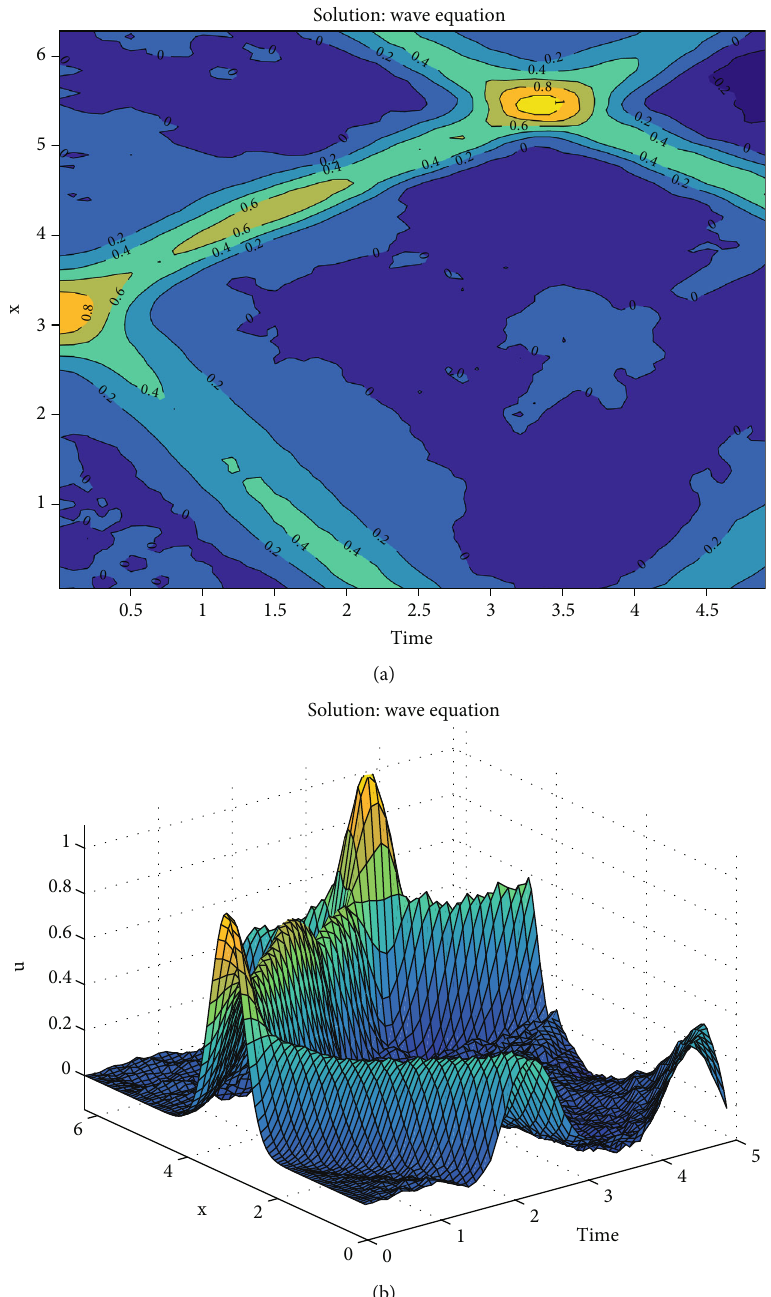
Figure 2: Plots for a single realisation of the stochastic wave equation. The settings are L = 2 π , N = 100 , δ x = L / N , δ t = 0 : 005 , and T = 1000 , μ = 0 : 01 , σ = 0 : 2 , C ð x Þ = e λ ð x Þ where λ ð x Þ = sin ð x Þ , and u